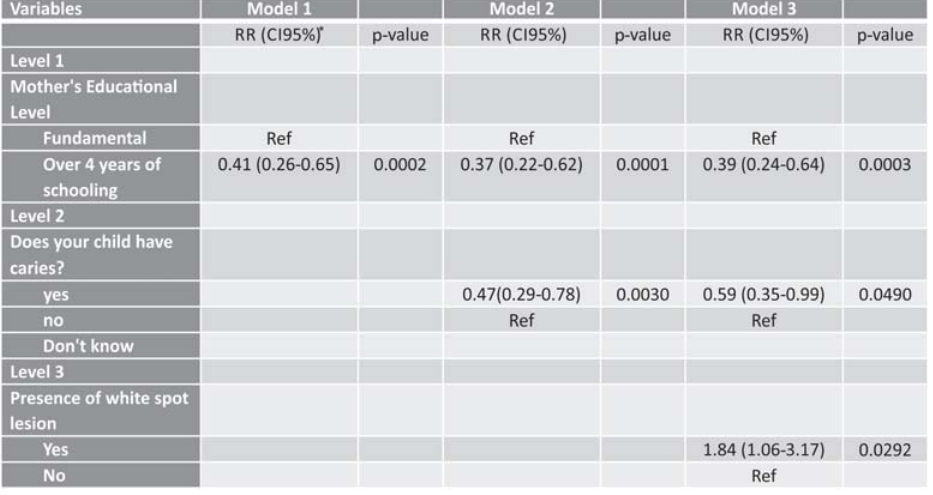
Table 4. Risk factors associated with incidence of dental caries analyzed by Generalized Estimating